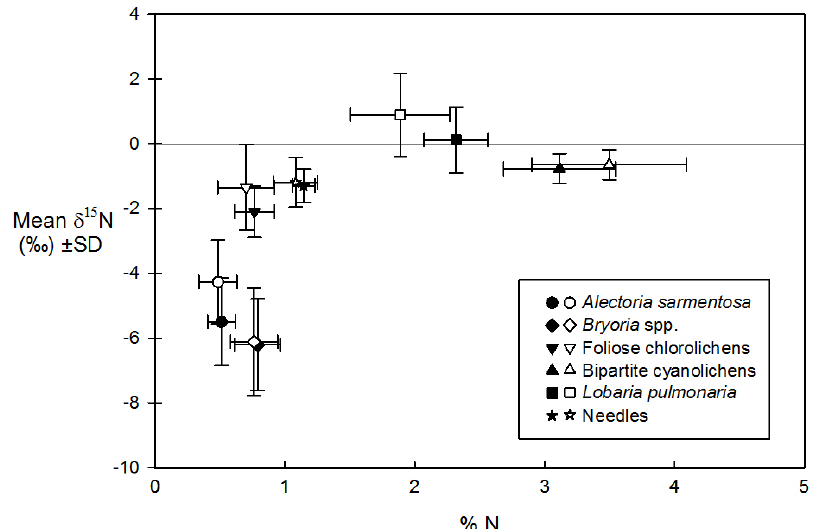
Figure 2. Mean (± SD) % N and δ 15 N signatures of five epiphytic lichen and host tree foliage (needle) biomasses across four sites and two host tree species from sub-boreal spruce and fir forests in central interior BC. Half of the host trees were from high (High Cyano: black symbols) and the other half from low (Low Cyano: white symbols) cyanolichen abundance